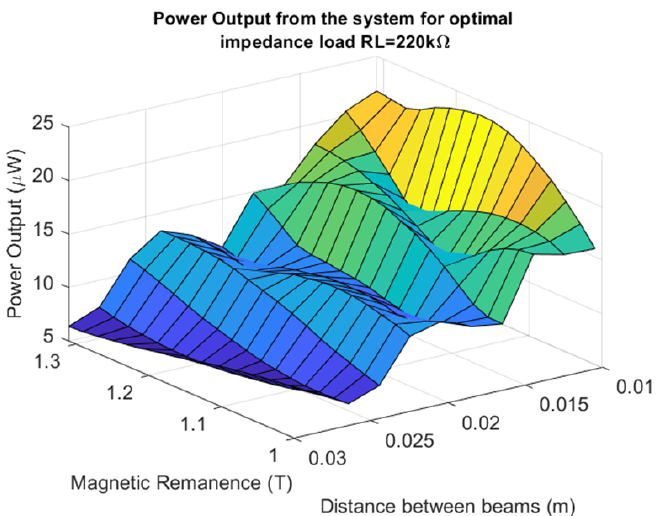
Figure 5. The power output generated by the EH system excited to vibration with the first natural frequency and connected to the optimal resistive load R L = 220 k Ω .